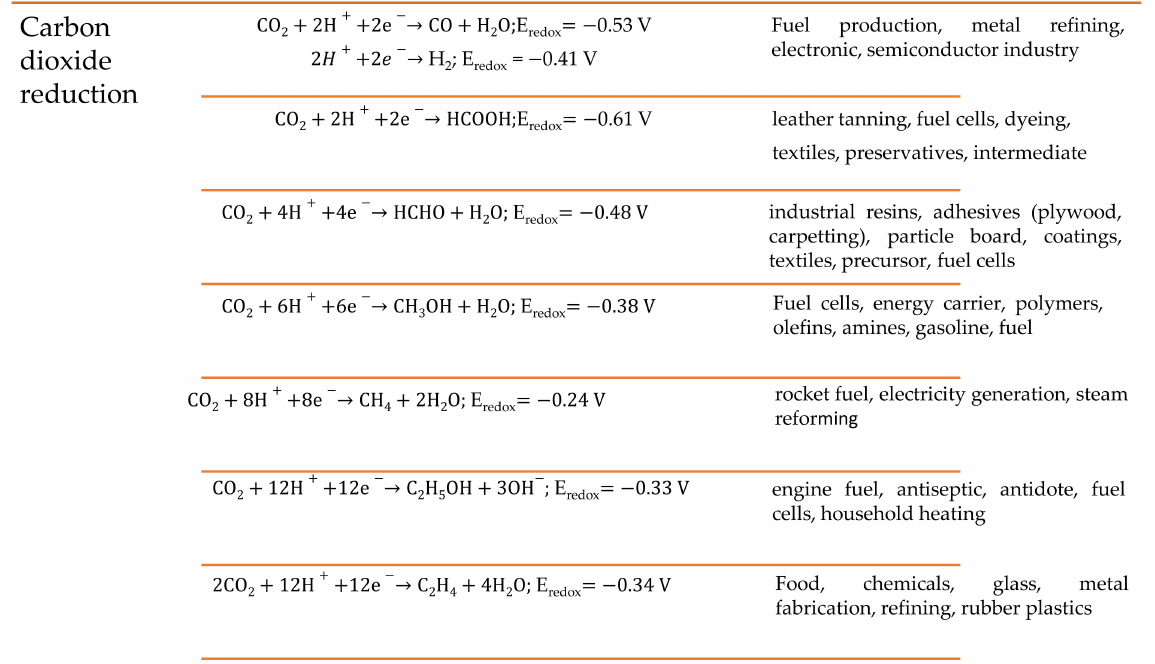
Figure 2. Summary of the possible CO 2 reductions with their redox potentials and